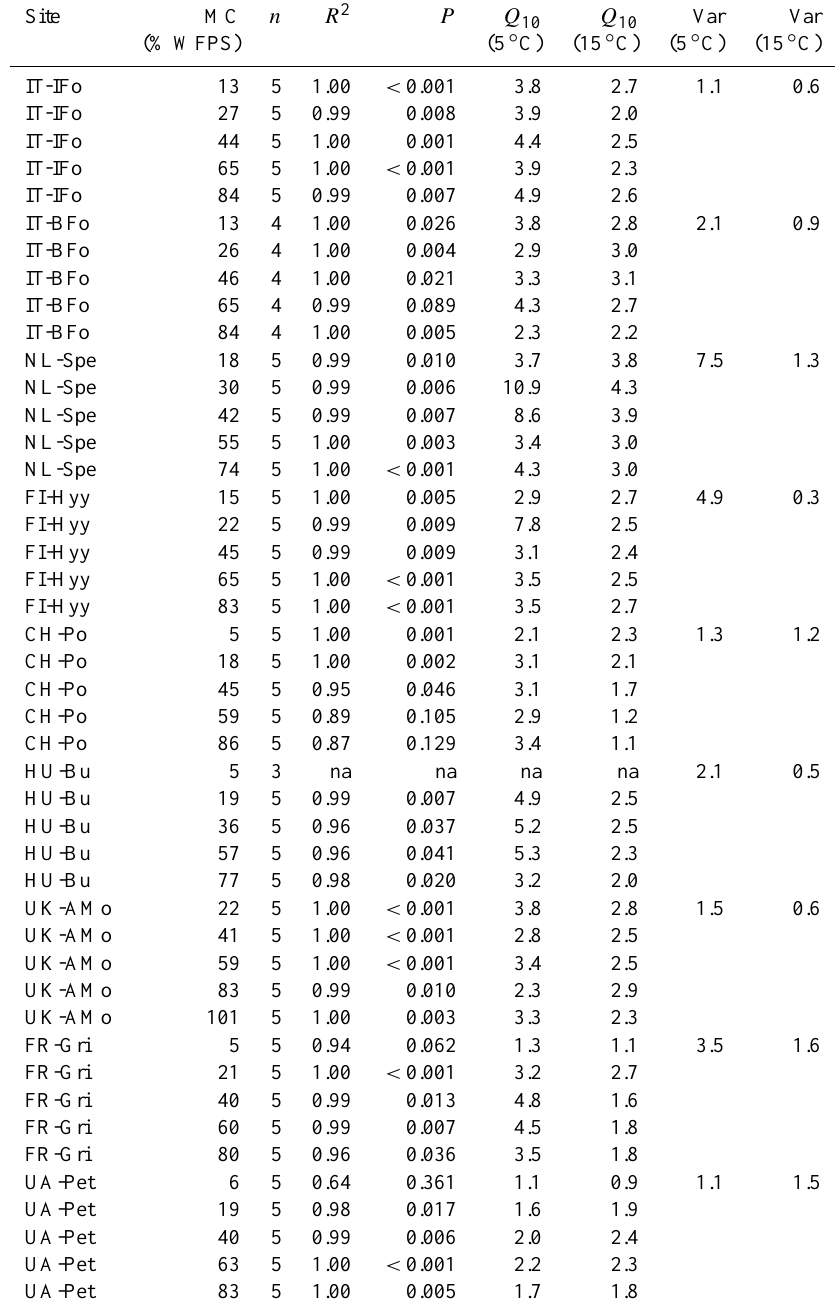
Table 3. Regression analysis of temperature relationship of heterotrophic soil respiration at all moisture contents (MC; shown in real values) investigated (Gaussian model equation); determination coefficient R 2 , standard error of estimate, significance level P , and number of ob- servations n (mean values over six replicants); Q 10 values at 5 and 15 ◦ C for all moisture contents and all sites investigated; and variability (Var) at 5 and 15 ◦ C. Variability was calculated as the highest Q 10 value at a certain temperature minus the lowest Q 10 value at a certain temperature ( Q 10,max − Q 10,min ). na: not